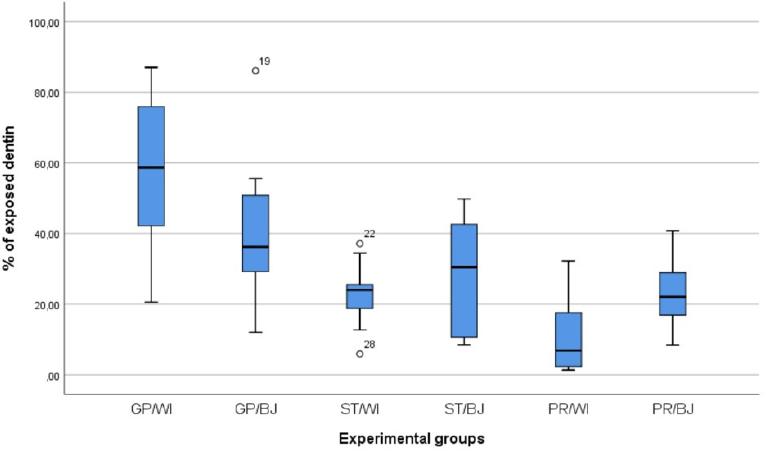
Figure 6. Box-plot chart showing values of the percentage of exposed dentin. Whiskers below and above box exhibit positions of minimum and maximum, whereas box spans show the first quartile to the third quartile. The median is represented by segments inside the box and suspected outliers are shown as unfilled circles. ST, undergraduate student; GP, general practitioner; PR, prosthodontist; WI, window; BJ, butt joint. Table 3. Results of 2-way ANOVA.